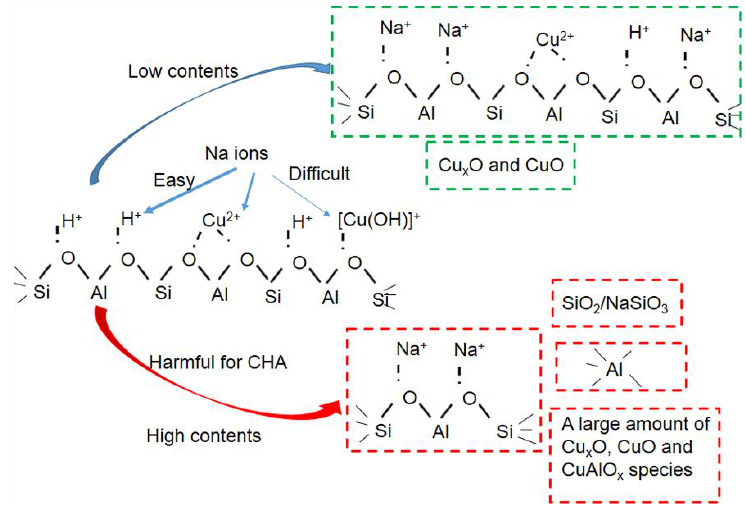
Scheme 1. Nature of the Na ions on Cu/SSZ-13